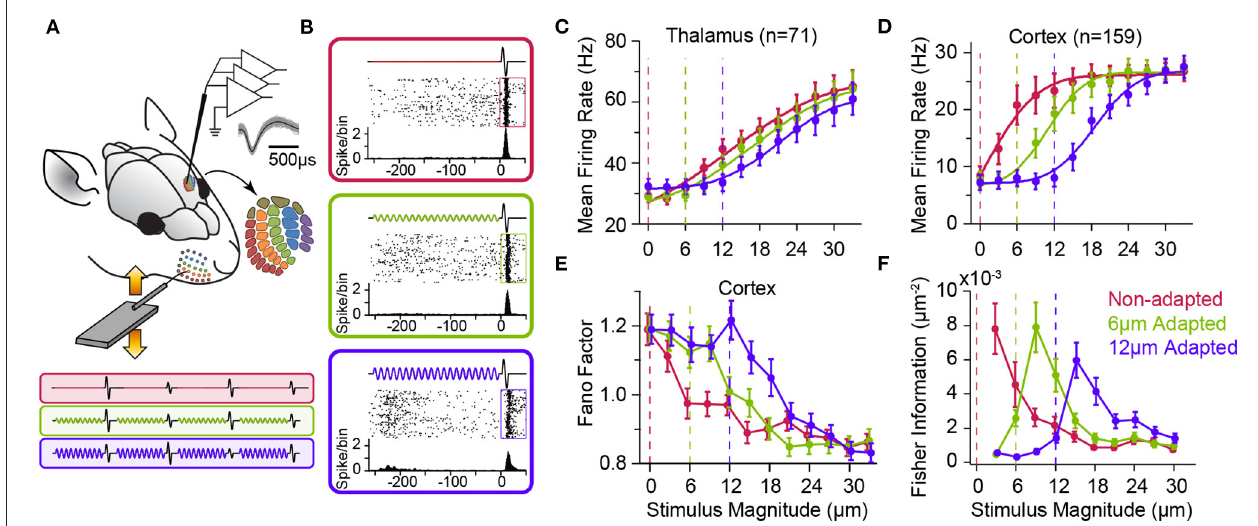
FIGURE 3 | Adaptation to sustained whisker stimulation generates systematic shifts in neuronal response statistics. (A) Extracellular multi-electrode array recording in rat whisker area of S1. The inset depicts the somatotopic organisation of barrels in layer 4 and infra-barrels in layer 6a, and the isolated spikes of a typical cortical neuron recorded from Barrel D4 while stimulating the principal whisker under three adaptation conditions (red: 0, green: 6 and magenta: 12 µm, 250 ms long at 80 Hz) followed by a single-cycle sinusoidal whisker vibration (0–33 µm). (B) Each panel shows response of the sample neuron to the 30 µm test stimulus in each adaptation condition. PSTHs are calculated in a 5 ms long bin sliding in 1 ms steps over 100 trials. (C) Adaptation shifts the response function of thalamic neurons. Vertical dashed lines represent the magnitude of the adapting stimulus. (D) Adaptation generates systematic shifts in the average population response function of S1 neurons. The response of simultaneously recorded units were averaged together to produce a population spike rate for individual sessions ( n = 8 comprising a total of 159 single- and multi-units). Spike rates are calculated in a 50 ms window after test stimulus onset (boxes in B ). (E) Trial-to-trial variations in neuronal responses of cortical single units ( n = 64) as captured by Fano factor (variance over mean spike counts across trials) exhibits a shift by adaptation. (F) The coding accuracy quantified by Fisher information peaks at amplitudes higher than that of the adapting stimulus. Single-neuron Fisher information as a function of stimulus magnitude ( n = 73 single neurons). All error bars indicate s.e.m. Modified from Adibi et al. (2013a) and Adibi et al.